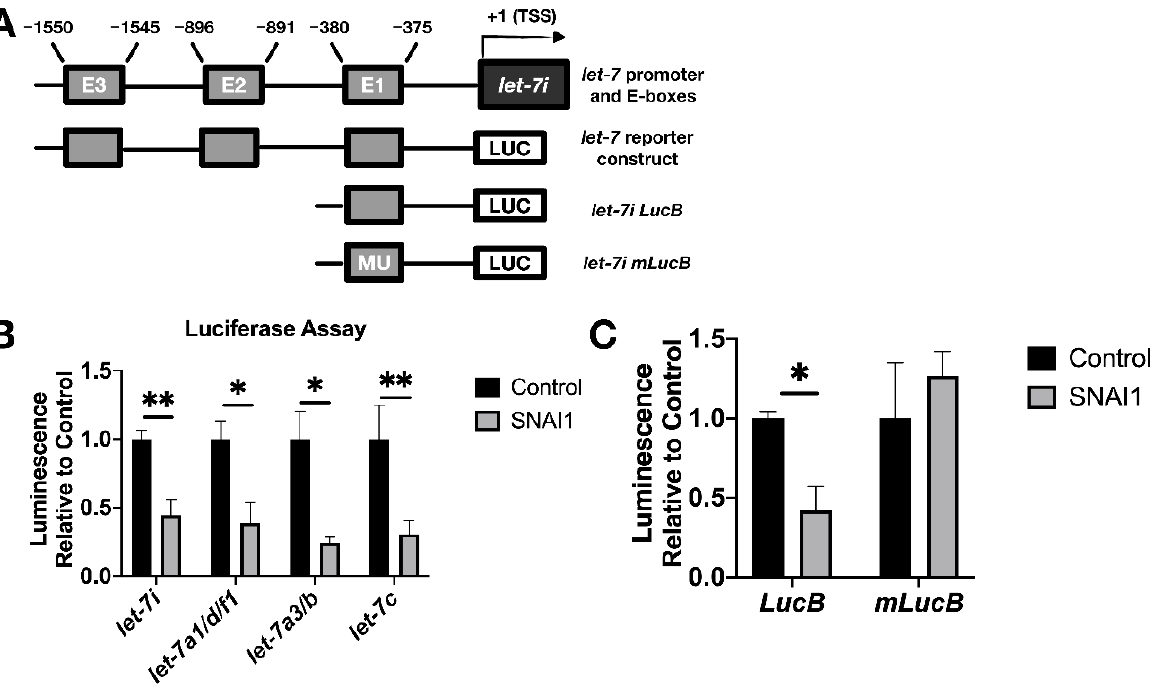
Figure 6. SNAI1 represses let-7 promoters. ( A ) Schematic representation of the promoter region of let- 7 i (upper) and reporter constructs used in luciferase assays (lower diagrams). E1, E2, E3: E-boxes (sequence: CANNTG); MU: Mutated E-boxes; TSS: Transcription start site ( B ) For luciferase assays, HEK293T cells were co-transfected with two plasmids: (1) let-7 promoter luciferase (let-7i, let-7a1/d/f1, let-7a3/b, let-7c) , and (2) either SNAI1 (constitutively expressed, gray bars) or empty vector (black bars). Luminescence activity was measured 48 h thereafter. ( C ) HEK293T cells were co-transfected with either let-7i lucB or let-7i mlucB with or without SNAI1. Luminescence was measured 24 h later. * p < 0.05; ** p < 0.01.